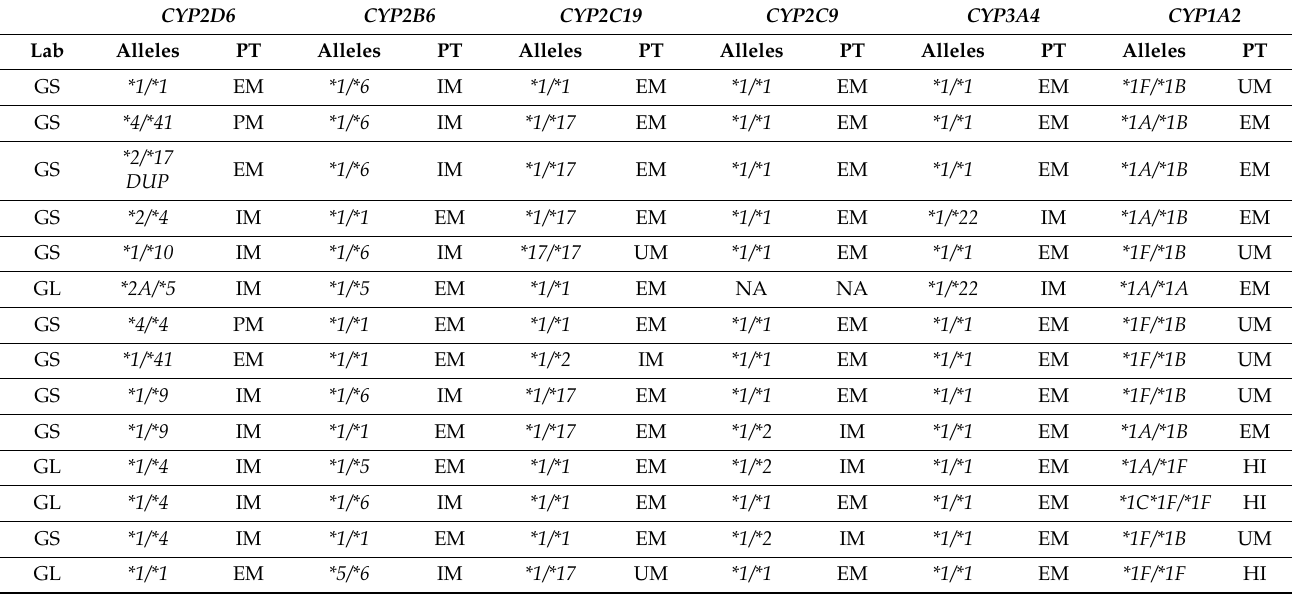
Table A2. Pharmacogenetic data for cytochrome P450 enzymes in PWS cohort with Deletion: Testing laboratory, CYP genotype, and CYP phenotype.